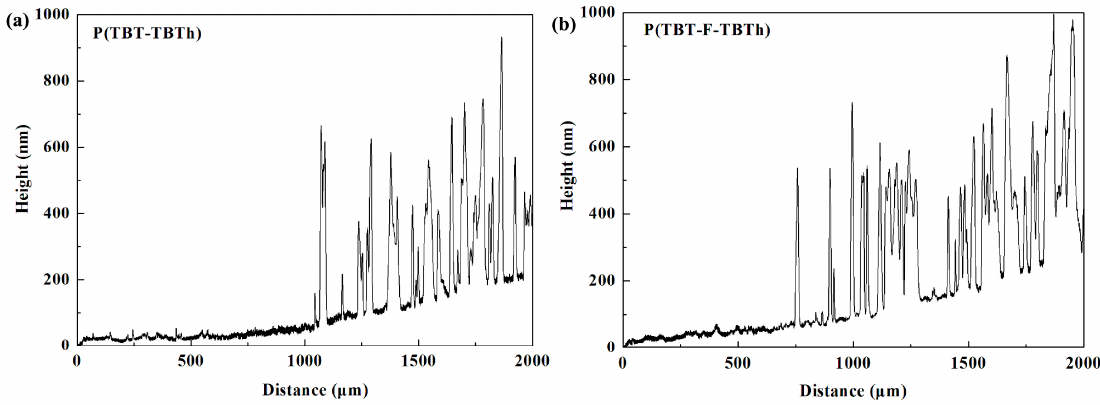
Figure 4. Film thicknesses of the polymers spray-coated onto the indium-tin-oxide (ITO) glasses: (a) P(TBT-TBTh); (b) P(TBT-F-TBTh).